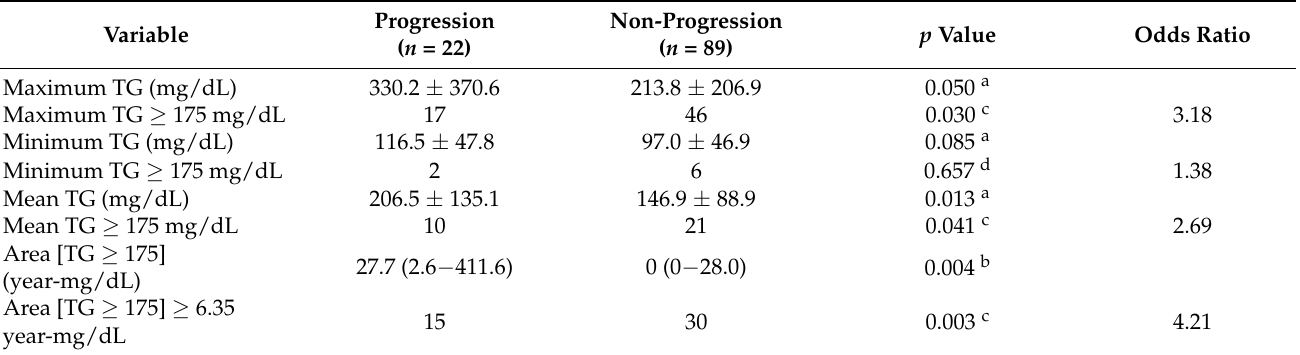
Table 2. Comparisons of non-fasting triglyceride (TG) profile during the follow-up period between the carotid stenosis progression and non-progressions groups.